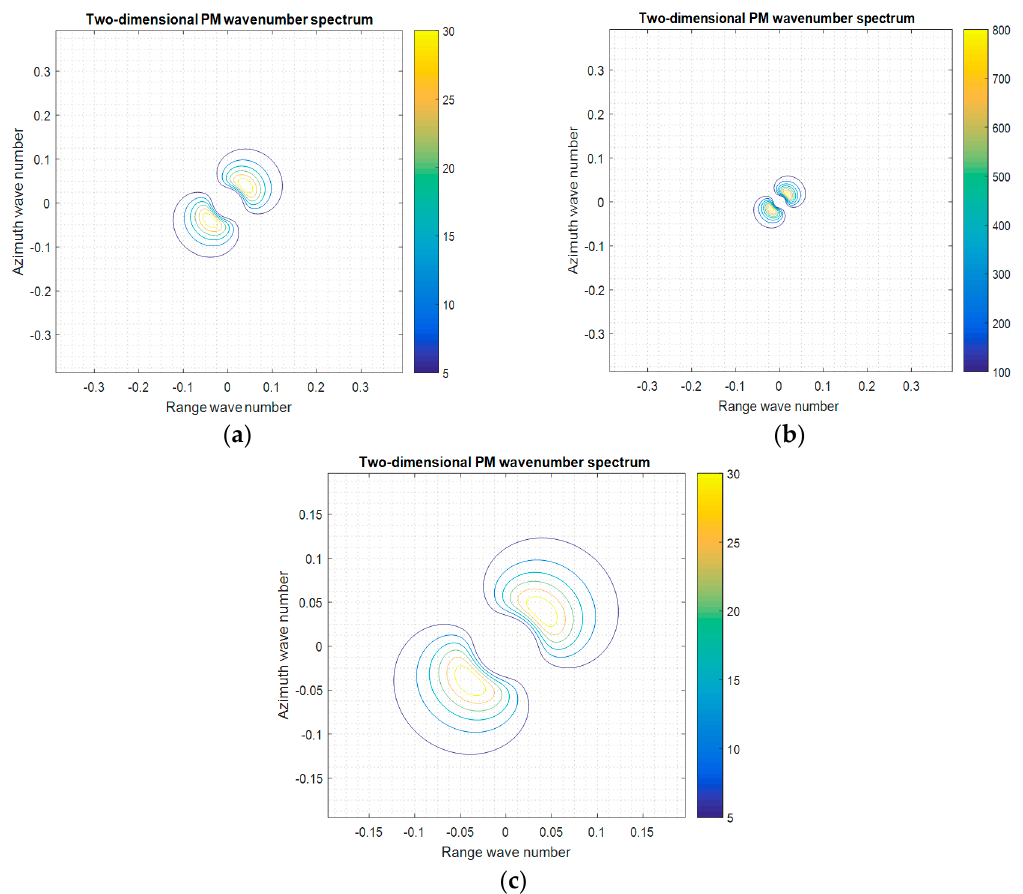
Figure 2. Two-dimensional (2D) PM wavenumber spectrum as follows: ( a ) 2D PM wavenumber spectrum at a wind speed of 10 m / s and a sampling pitch of 8 m, ( b ) 2D PM wavenumber spectrum at a wind speed of 15 m / s and a sampling pitch of 8 m, and ( c ) 2D PM wavenumber spectrum at a wind speed of 10 m / s and a sampling distance of 16